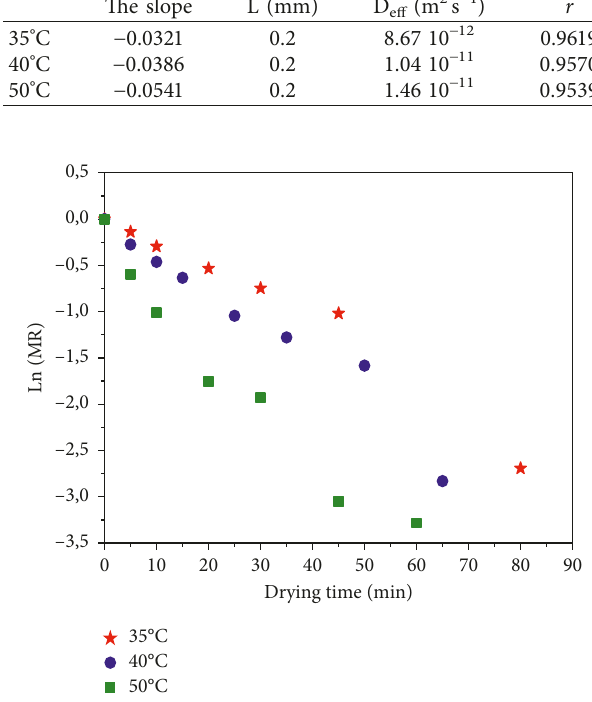
Figure 7: Plot of ln (MR) versus drying time for different drying air temperatures.